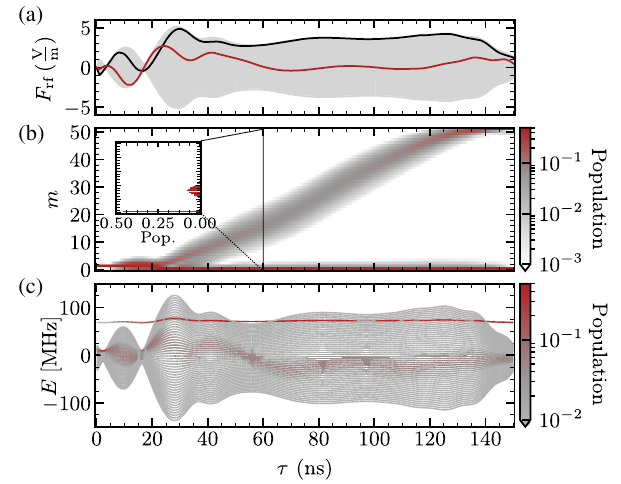
FIG. 7. Optimized cat state preparation pulse. (a) Amplitude of the two quadratures of the rf pulse given by the Krotov optimi- zation. Time evolution of the population of each Stark level of the lower diagonal (b) and of the instantaneous eigenstates of the atom-rf field Hamiltonian in the rotating frame (c), denoted as “ dressed states ” in the main text. The vertical position of the lines in (c) reflects the instantaneous energy of the corresponding state, and the color of a line shows its population at time τ . The inset in (b) presents the computed population histogram for the different m levels at τ ¼ 60 ns, showing that the pulse prepares, during the first few tens of nanoseconds, a superposition of m ¼ 1 and a spin coherent state made up of levels with m > 2 .